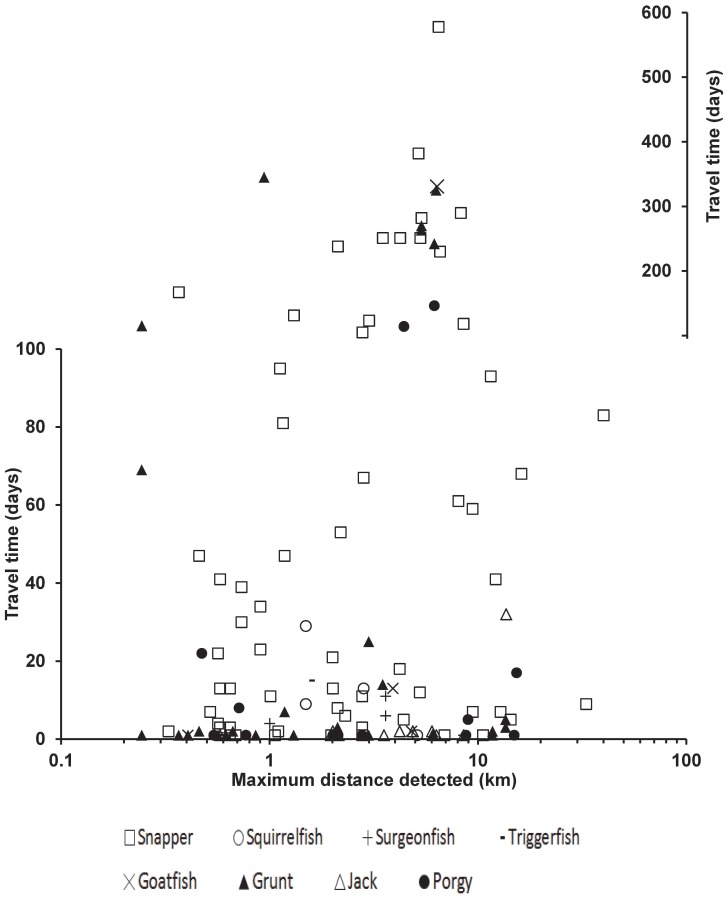
Distance and travel time between farthest receivers visited by acoustically tagged fish based on the time stamps of detections on the Caribbean acoustic array. Symbols identify fish family for0 each individual fish data point.